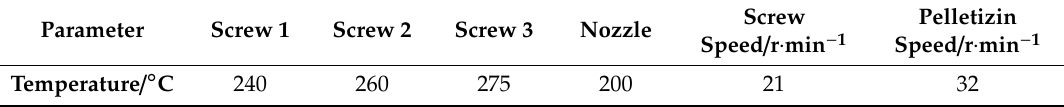
Table 1. Processing parameters of blending masterbatches.